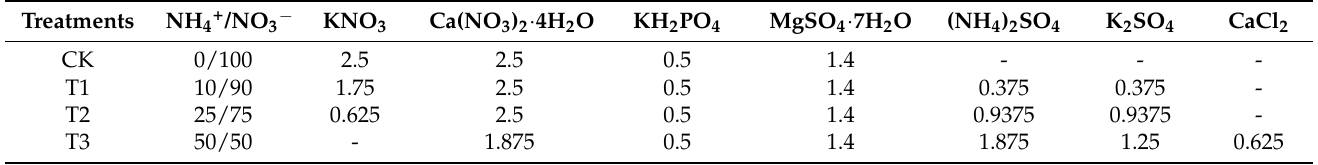
Table 1. Nutrient solution with different NH 4+ /NO 3 − ratios (Unit: